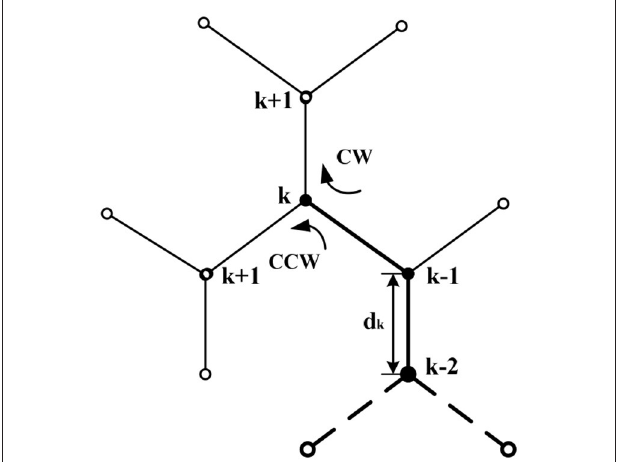
FIGURE 4 | The turning selection diagram.